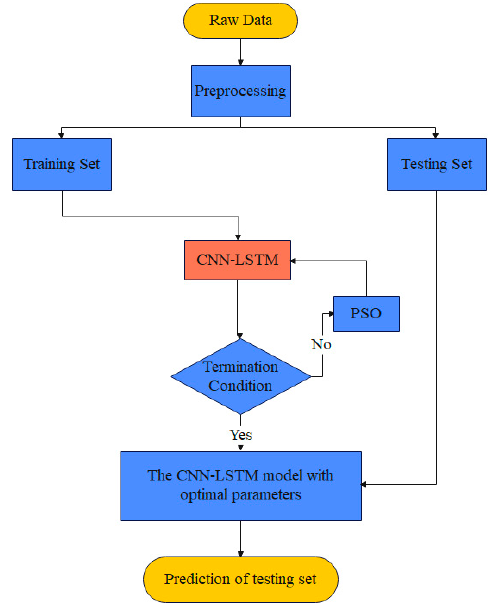
Figure 5. Overall workflow of our suggested model.